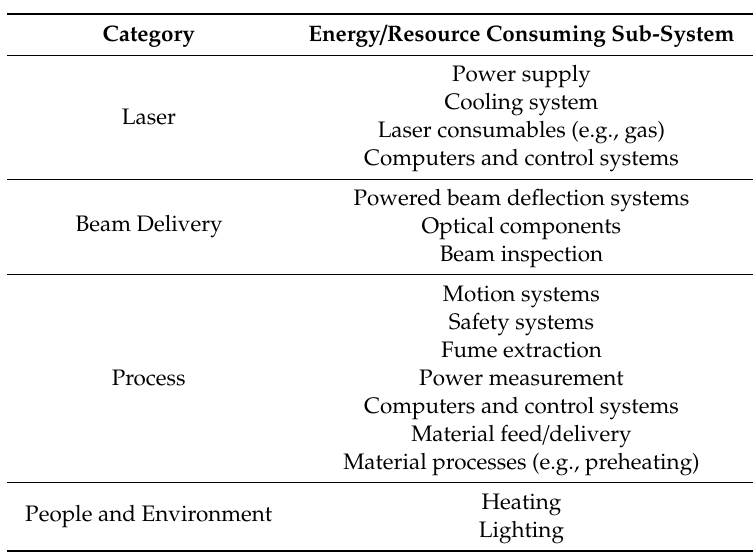
Table 1. Common laser